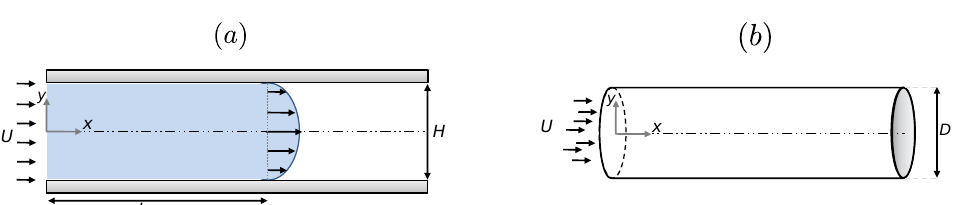
Figure 1. Schematic of the channel and pipe geometries used for the study of the development length. ( a ) Channel flow. ( b ) Pipe